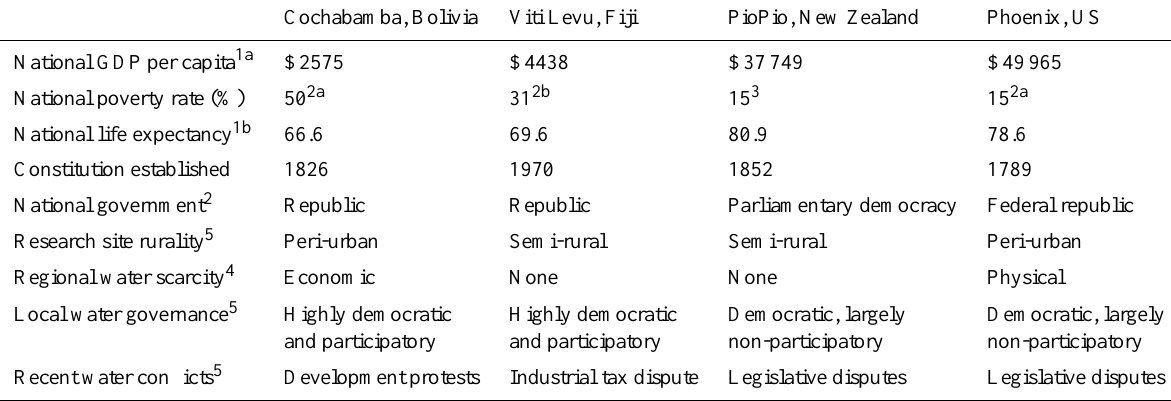
Table 1. Study site